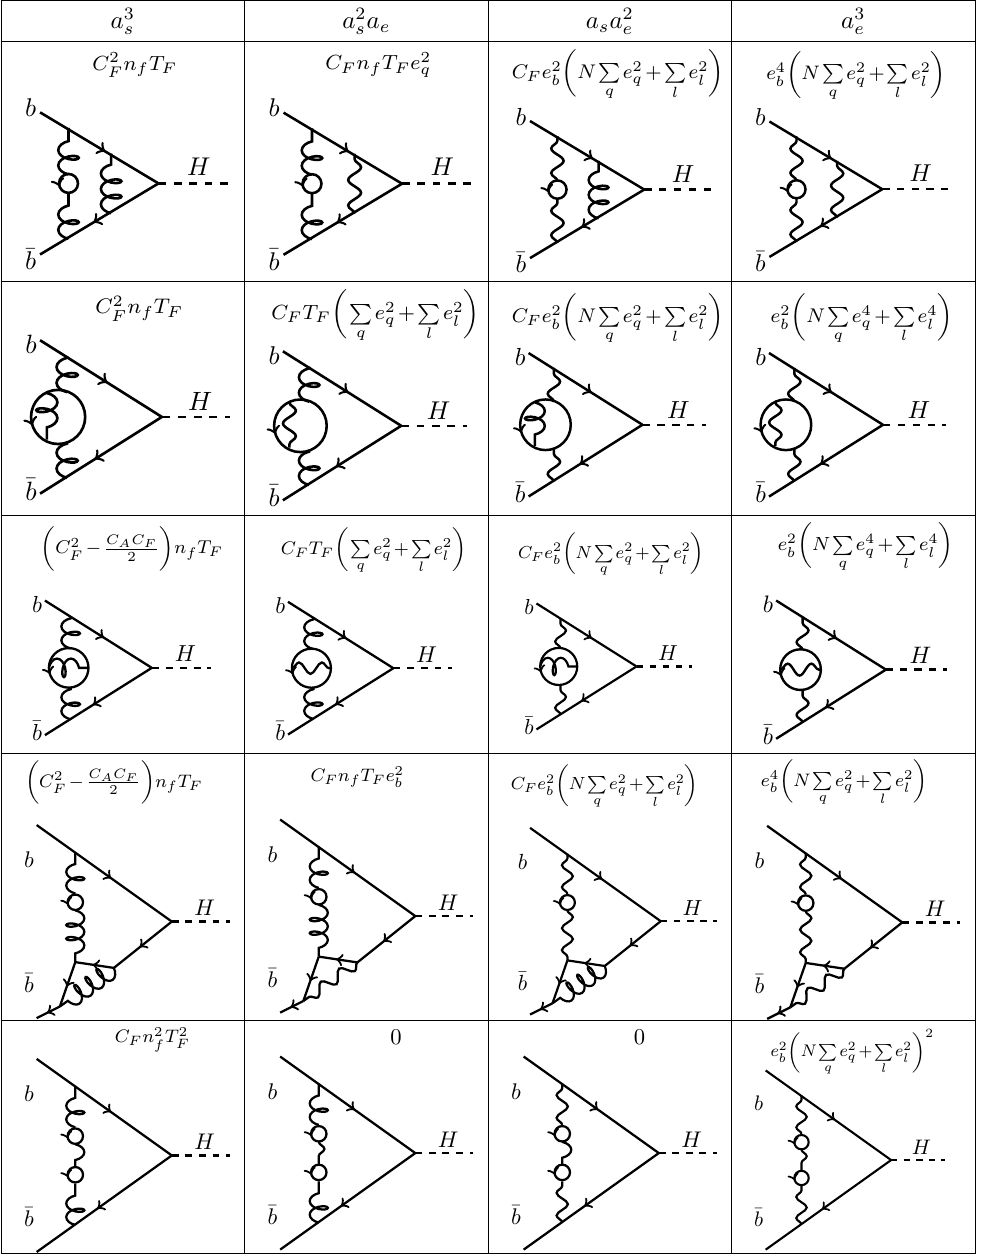
Table 2 . Flavour and charge distributions for some pure QCD, pure QED and QCD (cid:2) QED loop con(cid:12)gurations. Color factors are obtained for the b (cid:22) b channel after conjugating with born amplitude and taking the color average up to an overall 1 factor. N